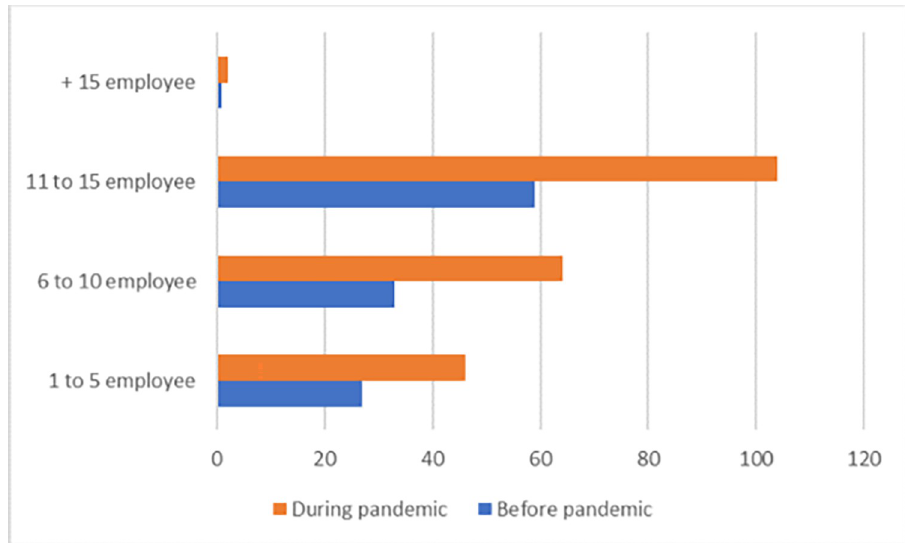
Fig 4. Employee related to supply chain. Source: By the